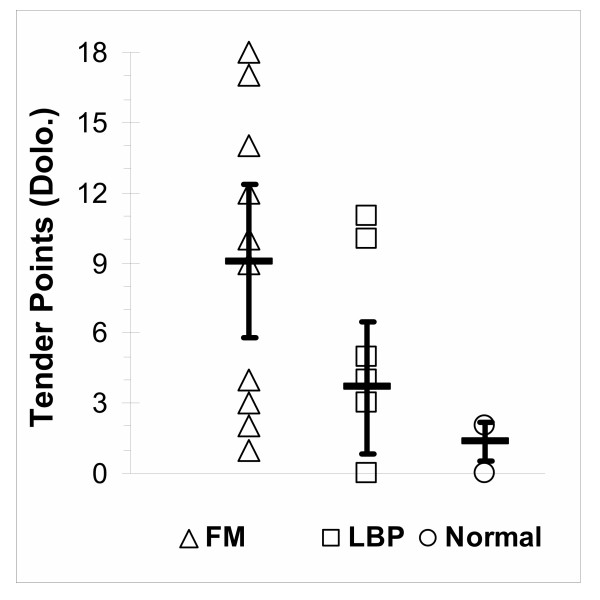
Tender points. The numbers of tender points detected by dolorimetry with ≤ 4 kg/cm2 pressure were higher for FM (triangles, n = 14), than LBP (squares, n = 9, p = 0.03) and Normal (circles, n = 6, p = 0.008) groups. The bars indicated means and 95%CI's.